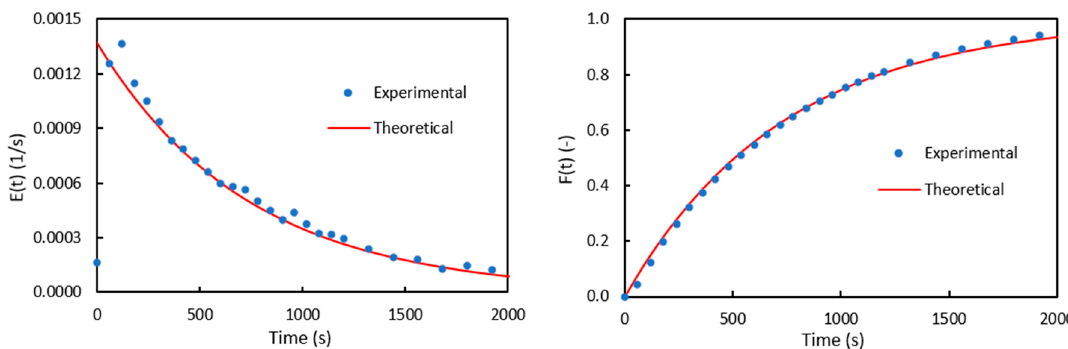
Figure 5. Experimental and theoretical E(t) ( left ) F(t) ( right ) curves for Test 2.